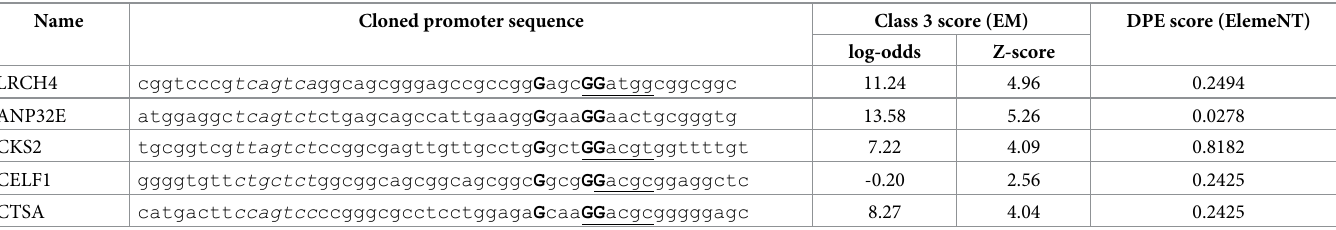
Table 1. Sequences used for testing activity of identified downstream positions.